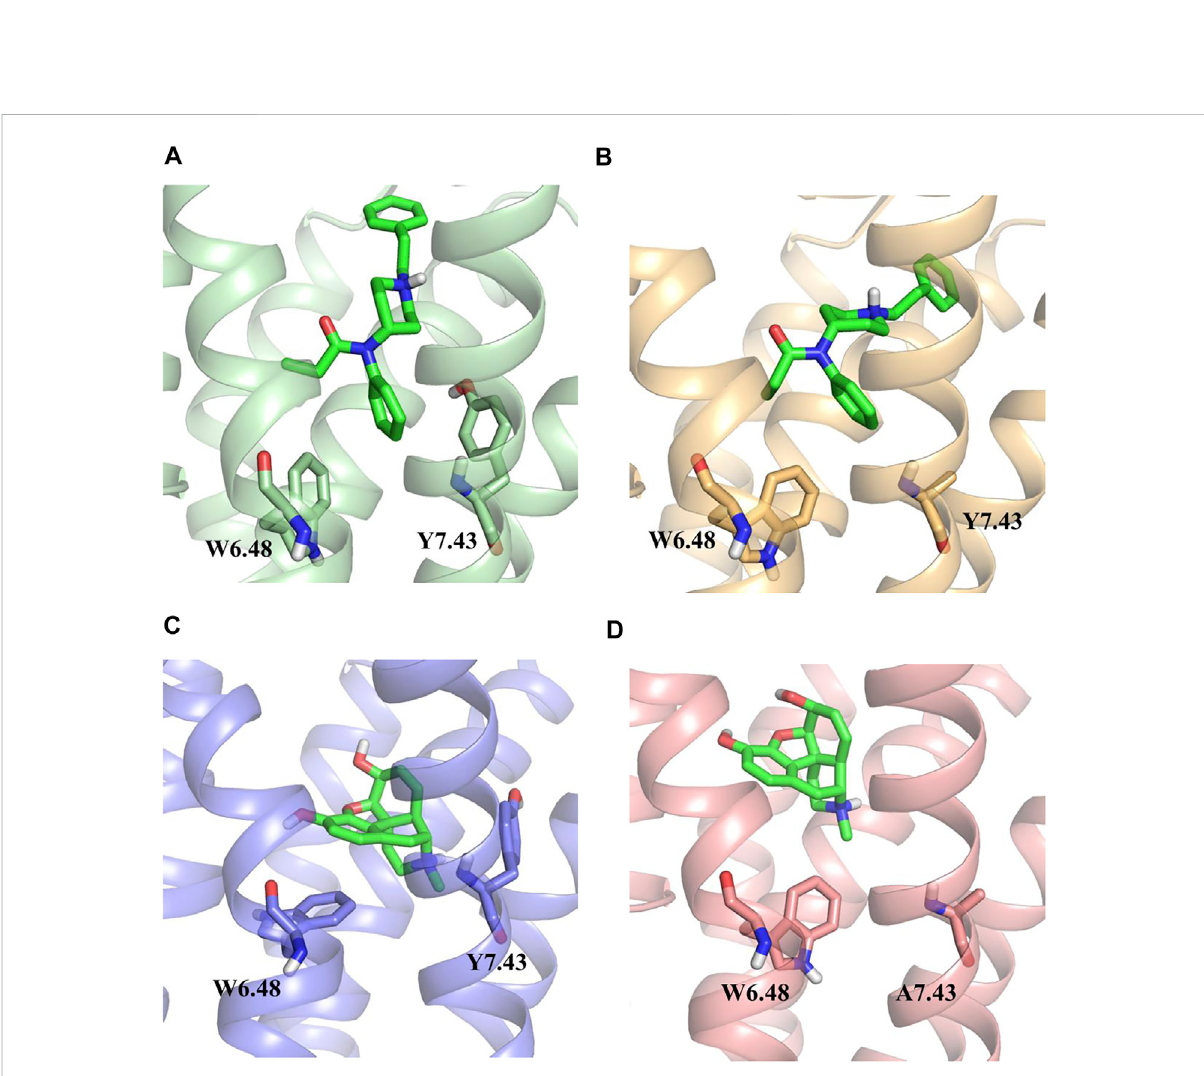
FIGURE 5 Hydrophobic interactions between W6.48 and Y7.43 during simulations. (A,B) hydrophobic interactions between W6.48 and Y7.43 during the binding process of fentanyl with µ-opioid receptor (MOR). Residues are shown in the ball – stick model; wild type (WT), green ribbon; Y7.43A, yellow ribbon. (C,D) hydrophobic interactions between W6.48 and Y7.43 during the binding process of morphine with MOR. Residues are shown in the ball – stick model; WT, light blue ribbon; Y7.43A, pink